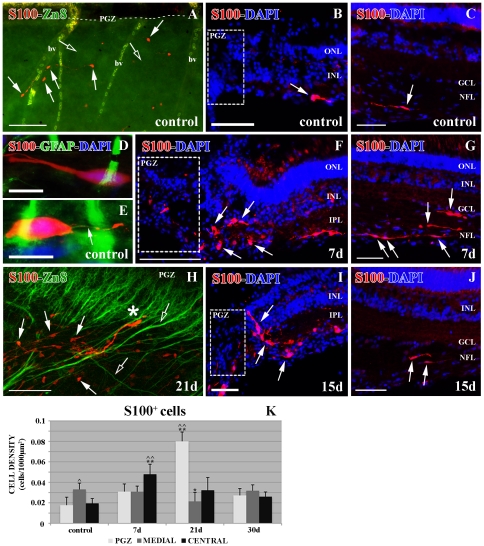
Double immunolabeling S100 (red)-Zn8 (green) and S100 (red)-GFAP (green) with DAPI (blue).(A) S100+ cells (arrows) and Zn8+ growing axons (empty arrows) in an in toto control retina, bv: blood vessels. PGZ: where this area is in the picture (broken line). (B) S100+ cell (arrow) in a control retina close to the PGZ. (C) S100+ cell (arrow) in control retina close to the ONH. (D) Detail of an S100+/GFAP− cell in the control retina. (E) Detail of an S100+ cell with GFAP+ processes (arrow) in the control retina. (F) S100+ cells (arrows) in the injured PGZ at 7 d post-cryolesion. (G) High quantity of S100+ cells (arrows) in the retina close to the ONH at 7 d post injury. (H) S100+ cells (arrows) and Zn8+ regenerating axons (empty arrows) in an in toto retina 21 d after the cryolesion. The asterisk indicates an S100+ cell directing its processes to the inner retina. Confocal, maximum projection of 18 optical planes acquired with a step size of 1 micron. A 40× oil inmersion objective with a N.A. of 1.25 was used and the pinhole was set to 1.20 Airy units. (I) S100+ cells (arrows) in the injured PGZ at 15 d post-cryolesion. PGZ: where this area is in the picture. (J) S100+ cells (arrows) in the retina close to the ONH 15 d post injury. (K) Statistical analysis of the S100+ cell density in the retina during regeneration. The cap and two caps indicate the significant (∧0.01<p<0.05) or highly significant (∧∧p<0.01) differences among the three regions in control and regeneration retinas; the asterisk or two asterisks mean that the differences in each region of the retina between the injured and controls are significant (*0.01<p<0.05) or are highly significant (**p<0.01), respectively. N = 5 animals per group. Scale bars: A: 100 µm; B–C, F–G, I–J: 50 µm; D–E: 10 µm; H: 75 µm. GCL: ganglion cell layer; INL: inner nuclear layer; IPL: inner plexiform layer; NFL: nerve fiber layer; ONL: outer nuclear layer; PGZ: proliferative growth zone.